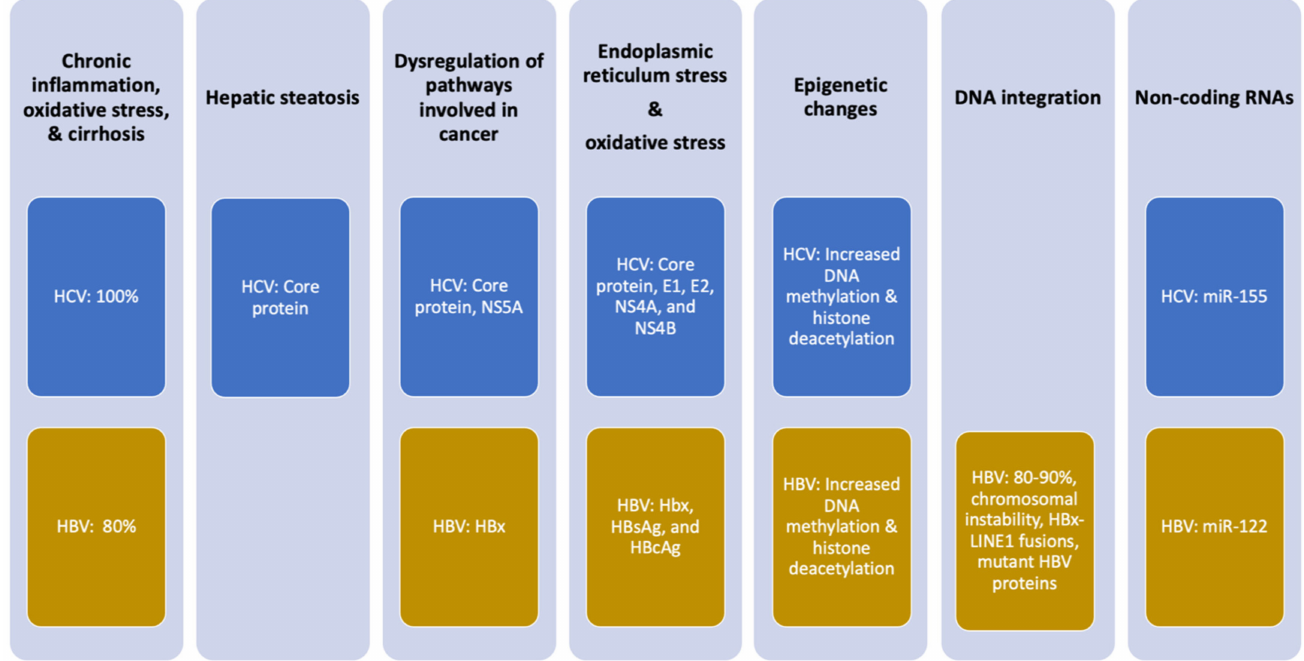
Figure 1. Mechanisms of oncogenesis by HCV and HBV. Percentages indicate the frequency with which the effect is observed in patients with infection-associated HCC. Viral proteins implicated in the oncogenic mechanism are